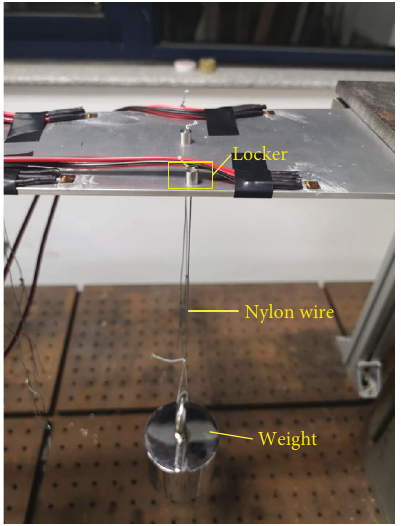
Figure 6: Static loading